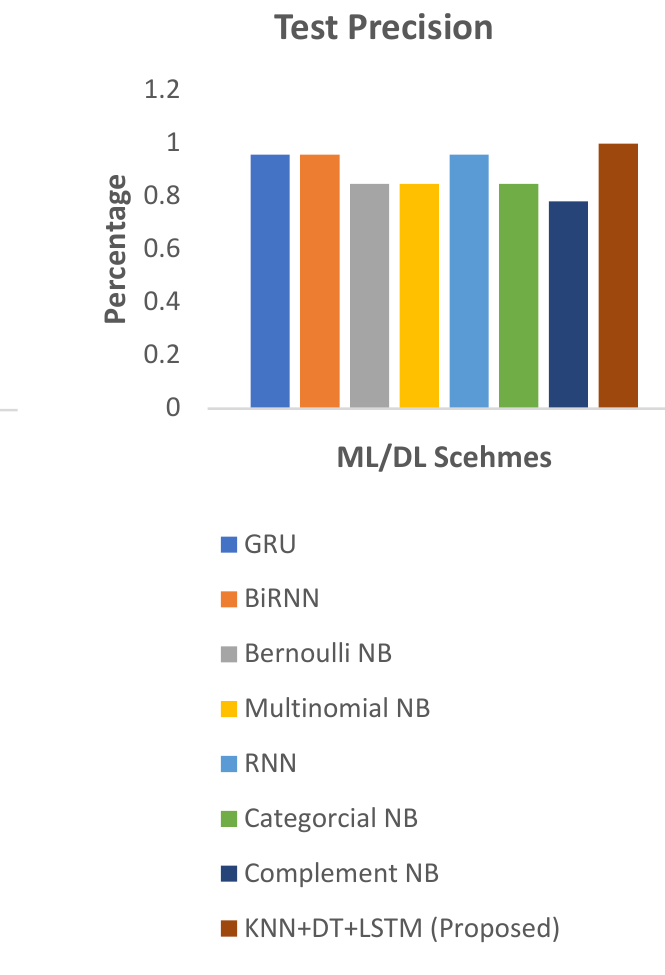
Figure 13. Training and Test Precision of Different Models. Figure 13: Training and Test Precision of Different Models. Recall is the capability of classifying positive samples relative to the total number of positive samples. In the current scenario, it is the ability to detect benign samples. Figure 14 shows the training and test recall of different